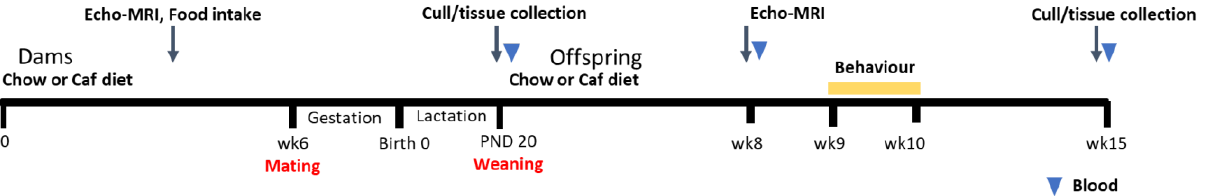
Figure 13. Experimental design. After exposure to chow or a Caf diet for six weeks, female rats were mated with lean male rats, maintained on their diet throughout gestation and lactation and then euthanised three weeks post-partum. Offspring were weaned onto chow or Caf diet, forming four groups (ChowChow, ChowCaf, CafChow, CafCaf), where the first word refers to maternal diet and the second to offspring postweaning diet. Tissues were collected from male and female offspring at PND 20 and 15 weeks to examine the effects of maternal obesity. Offspring underwent Echo-MRI scanning (fat/lean mass) at eight weeks of age, and behavioural tests at 9 – 10 weeks of age.